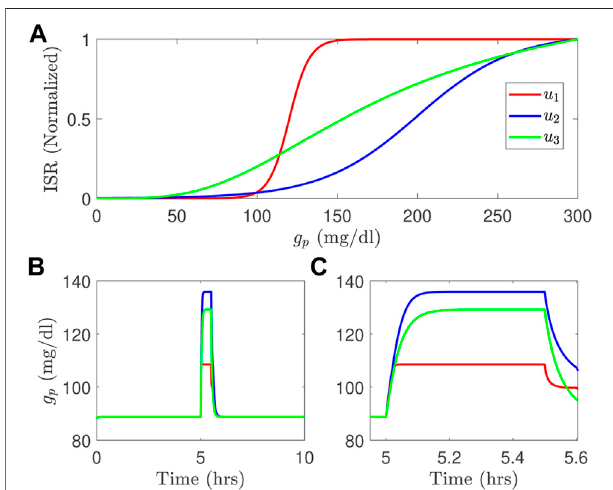
FIGURE 1 | Three different ISR functions (A) generate blood glucose variations, in long time course (B) and short time course (C) simulated using the model developed by Topp et al. (2000) with a meal; u 1 is the ISR function adoptedfromLiuetal.(2009); u 2 istheISRusedinToli ć etal.(2000),and u 3 is the ISR function used in the model of Ha et al.